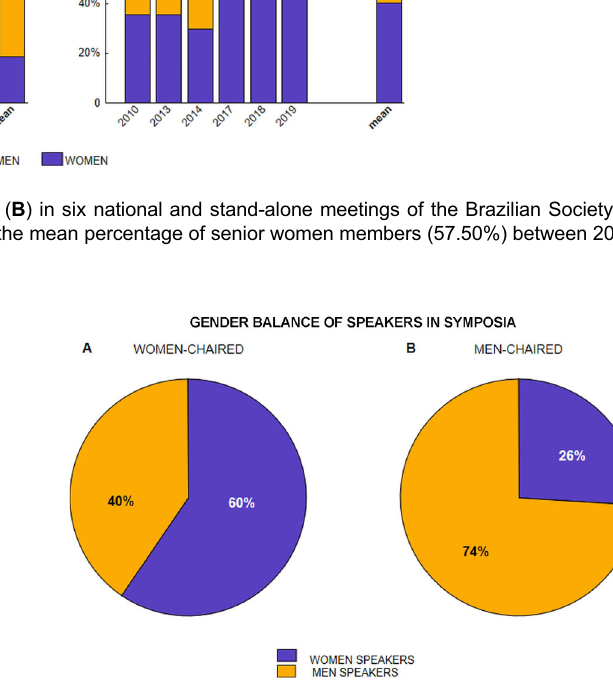
Figure 4. Gender balance of speakers in women-chaired symposia ( A ) and men-chaired symposia ( B ). Percentages were calculated by summing the number of male and female speakers at all six evaluated meetings